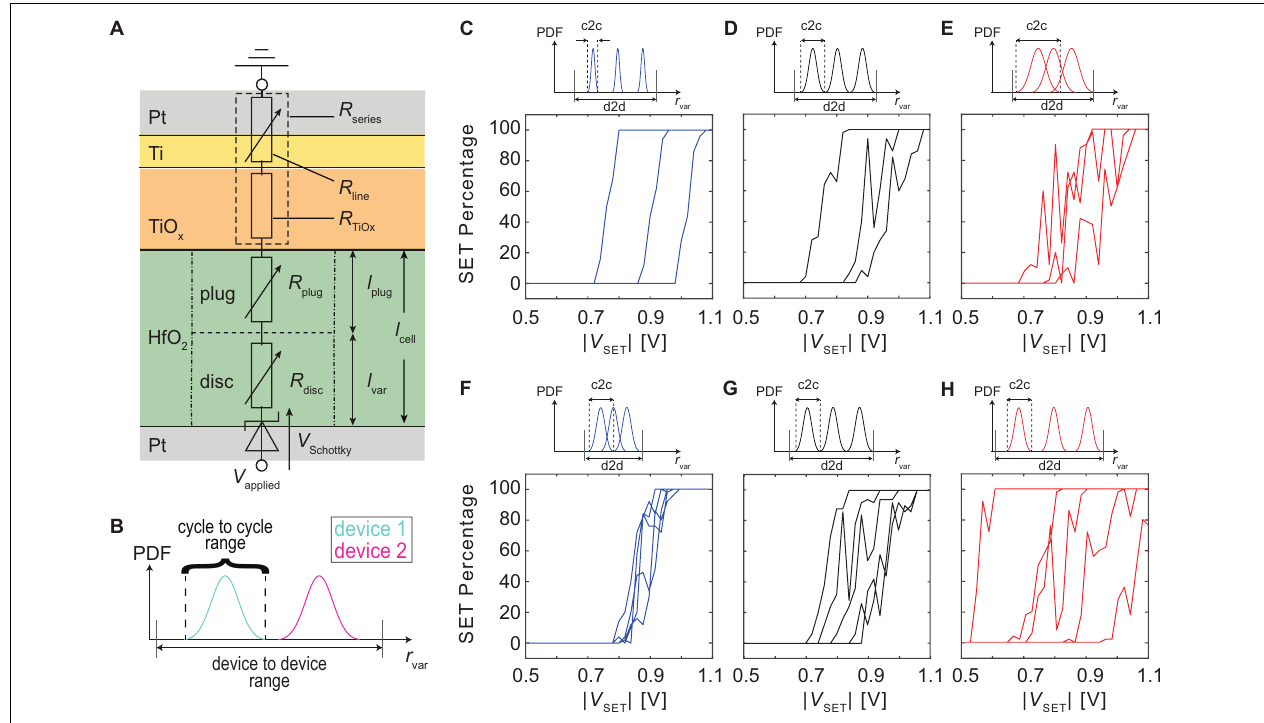
FIGURE 1 | (A) Shows the equivalent circuit diagram of the JART VCM v1b model used to describe a Pt/HfO 2 /TiO x /Pt (HOTO) device. The exact stack properties can be found in Hardtdegen et al. (2018). (B) Schematically shows the modification made to the variability model exemplary for the variability model parameter r var . For each device, a seed parameter is drawn from the d2d range. Around this seed parameter, the cell can change its variability parameters by the smaller c2c range. (C–E) Show the effect of different amounts of the c2c variability on the SET probability behavior for three cells. For (C) , the c2c percentage was 5%, for (D) it was 15%, and for (E) it was 25%. (F–H) Show the effect of different amounts of d2d variability. This was achieved by decreasing the d2d range and the variation coefficient for (F) . For (G) the values from Table 2 were chosen and for (H) the d2d range was increased. The changes are conceptually shown by the small PDFs given on top of diagram (C–H)